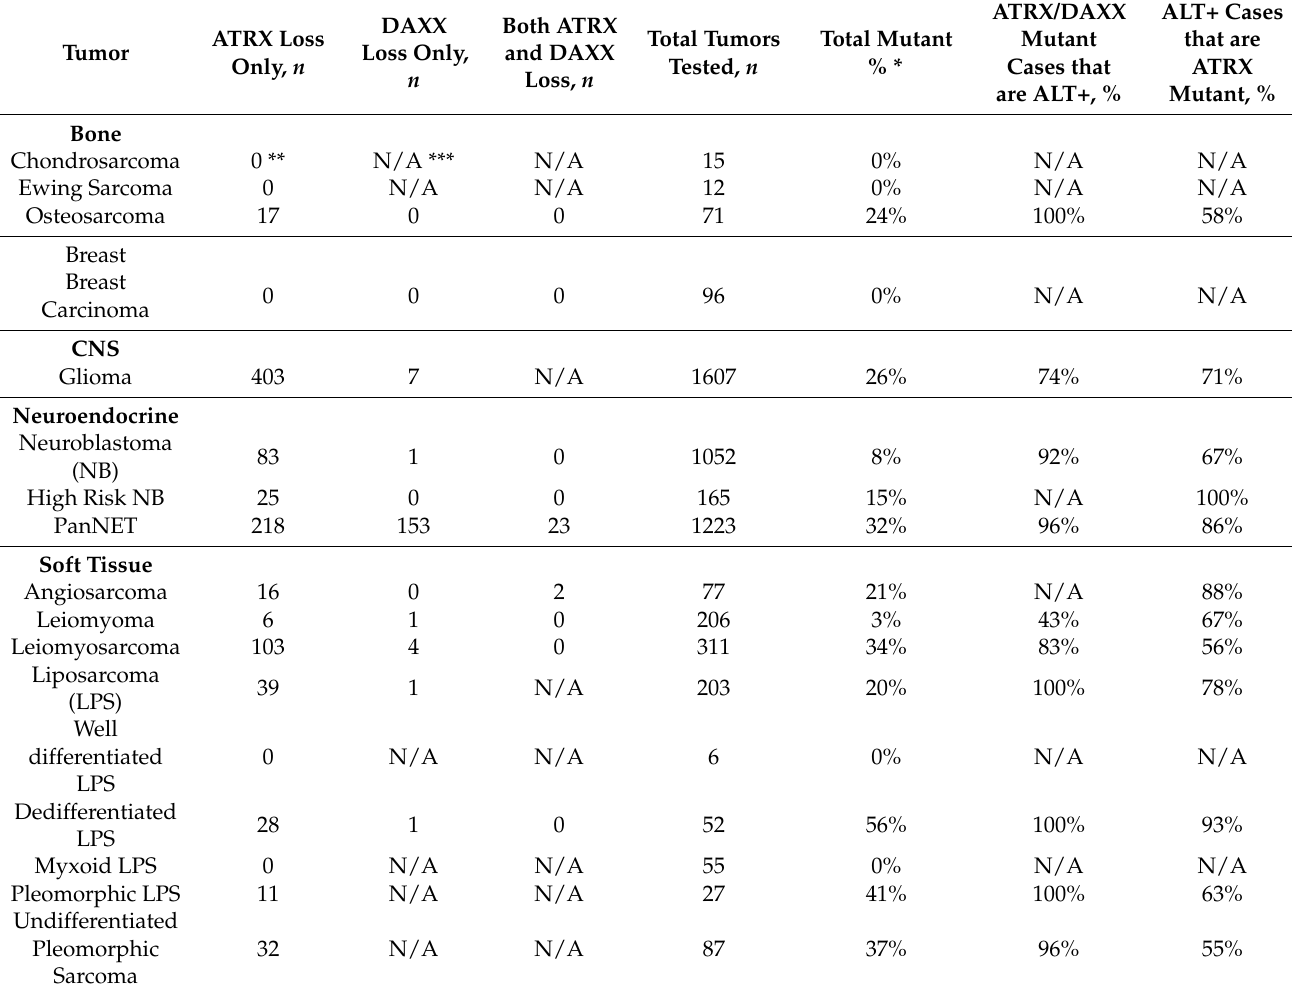
Table 3. ATRX/ DAXX loss in ALT-associated human